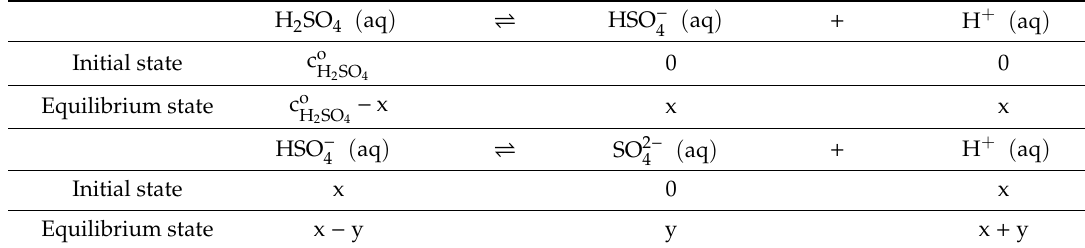
Table A2. Material balance of sulphuric acid